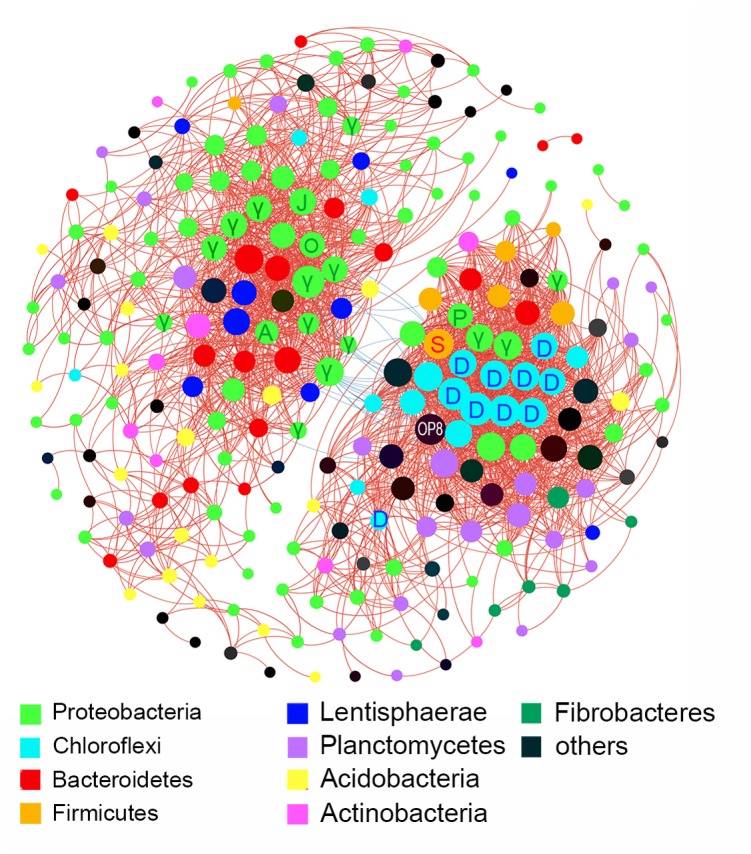
Inter-taxa relation network with thresholds of ±0.7 for Spearman’s coefficient and 0.01 for P-value. Correlations between families were represented by colored lines between nodes (red for positive, blue for negative). Size of node depended on the number of connections. A, Alteromonadaceae; D, Dehalococcoidia; γ, Gammaproteobacteria; J, JTB255; O, Oceanospirillaceae; P, Pseudomonadaceae; S, Streptococcaceae.